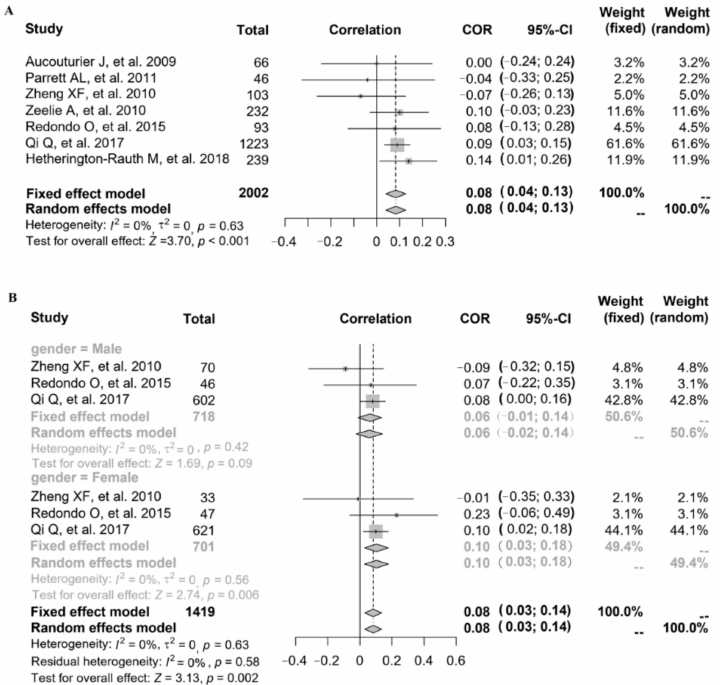
Figure 2. The relationship between FMP and FPG: ( A ) 7 studies (study ID: 1–7) [18–24] provided the correlation coefficient ( r ); ( B ) stratified by gender in 3 studies (study ID: 2, 6, 7) [19,23,24].